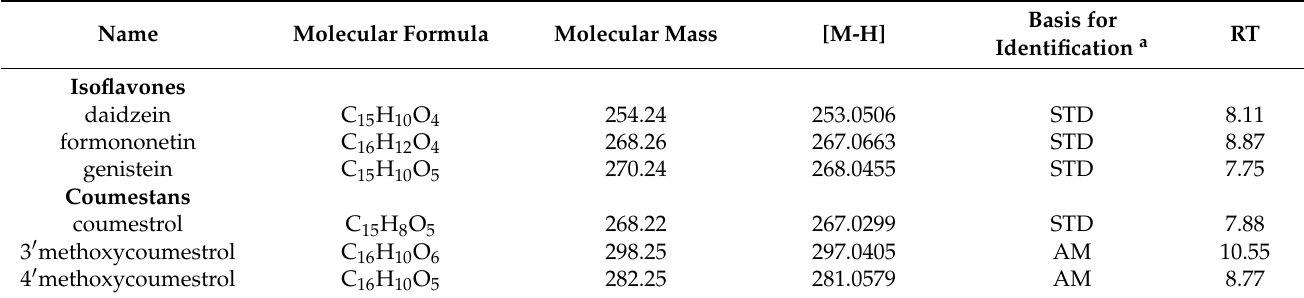
Table 5. Phytoestrogens from pasture legume species were identified in this study by UHPLC-QTOF-MS in positive ionization mode.